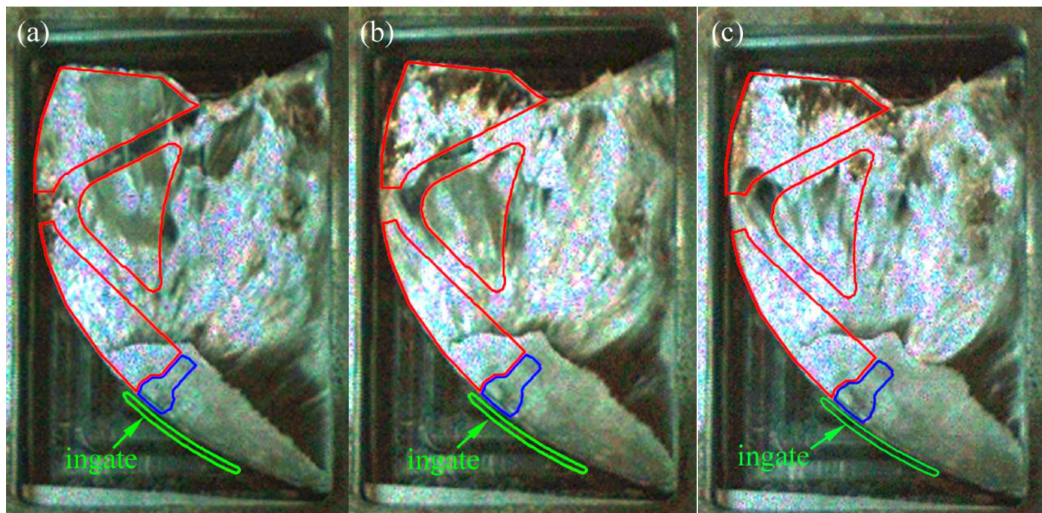
Figure 7. Flow pattern under the fast shot velocity of 0.88 m/s in the left window. ( a – c ) are arranged according to the order of